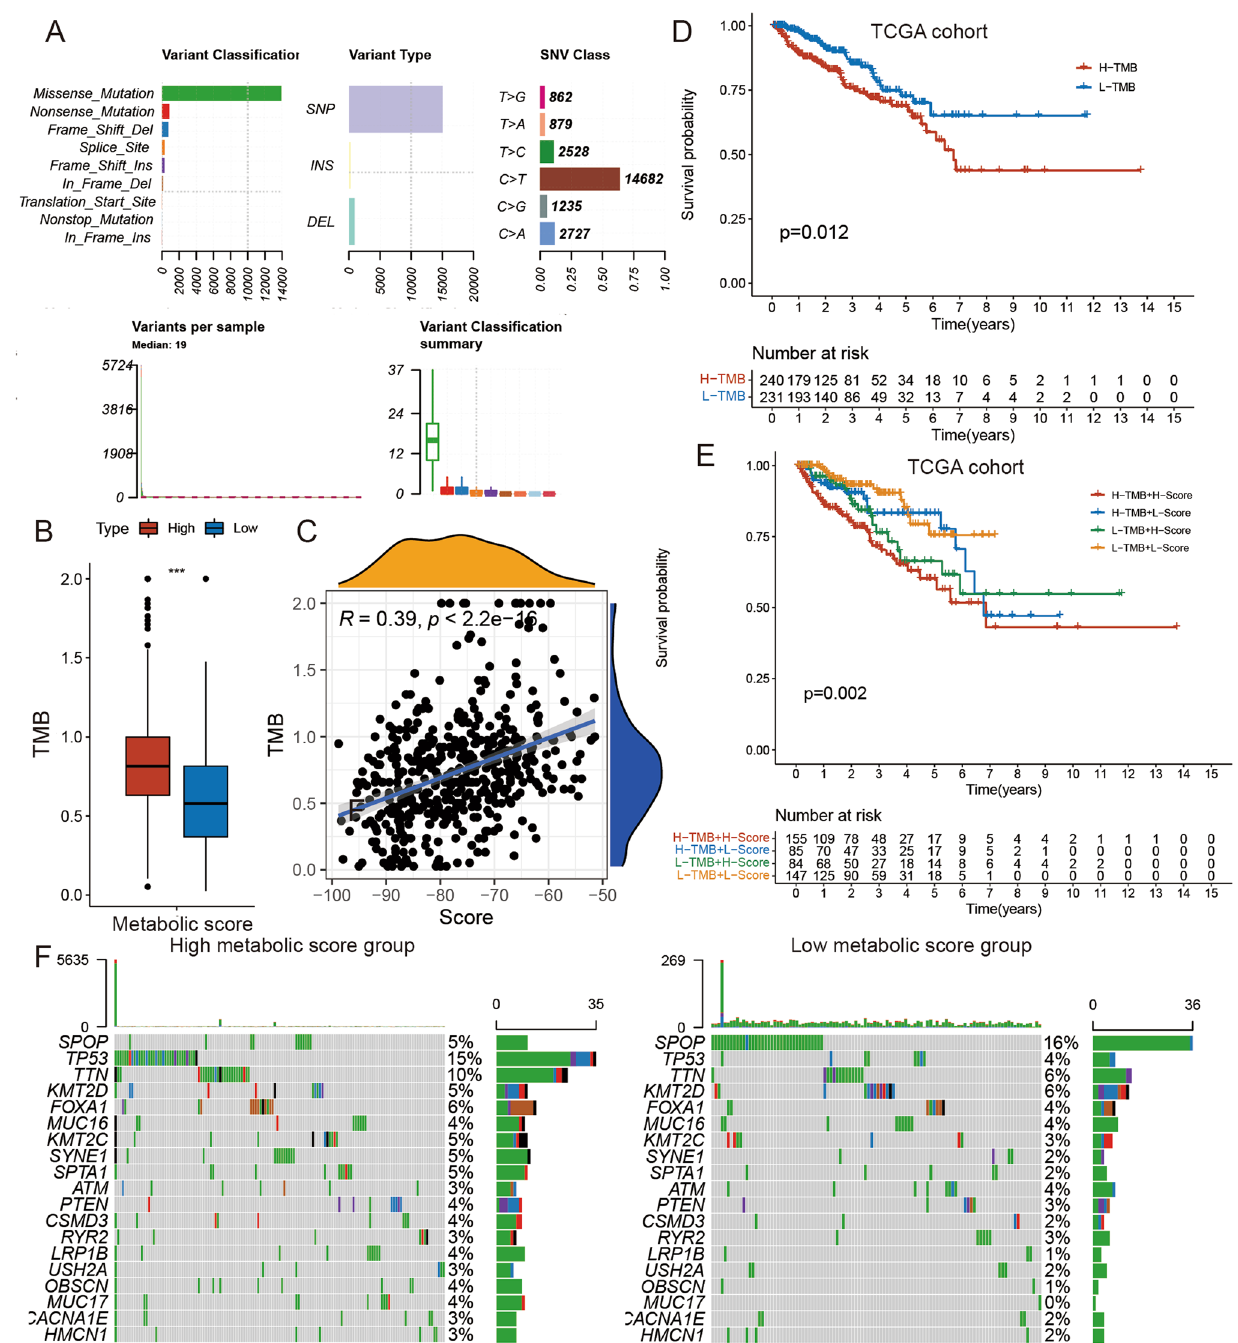
Figure 5. The Correlation between the metabolism-score and somatic variants in TCGA cohort. ( A ) The summary information of Somatic Variants in TCGA cohort. ( B ) TMB difference in the high and low metabolic score subgroups. Wilcoxon test, p < 0.001. ( C ) Scatterplots are depicting the positive correlation between metabolism-scores and mutation load. The Spearman correlation between metabolic scores and mutation load is shown ( p < 0.001). ( D ) Kaplan–Meier curves for high and low TMB groups. Log-rank test, p = 0.012. ( E ) Kaplan– Meier curves for patients stratified by both TMB and metabolism-scores. Log-rank test, overall p = 0.002. ( F ) The oncoPrint was constructed using high metabolic scores on the left and low metabolic scores on the right. Individual patients are represented in each